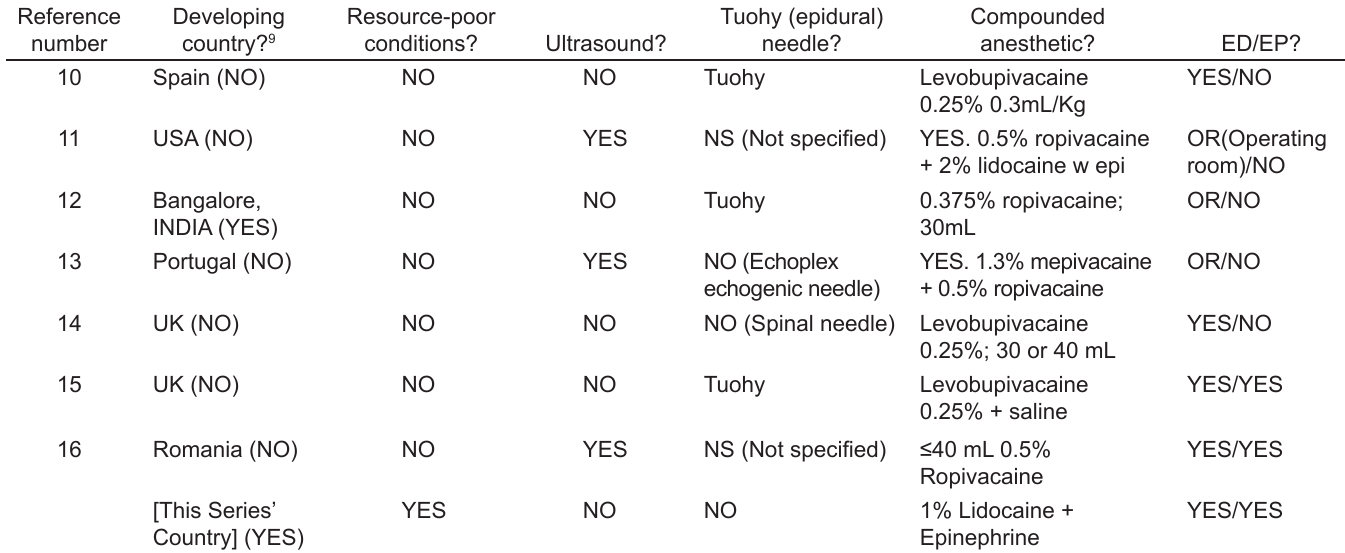
Table. Comparison of current case series with recent (2016-2018)